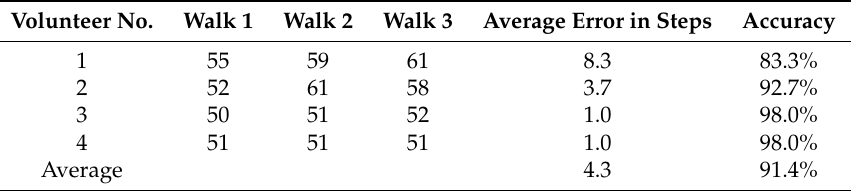
Table 16. Step detection using a Motorola smartphone.